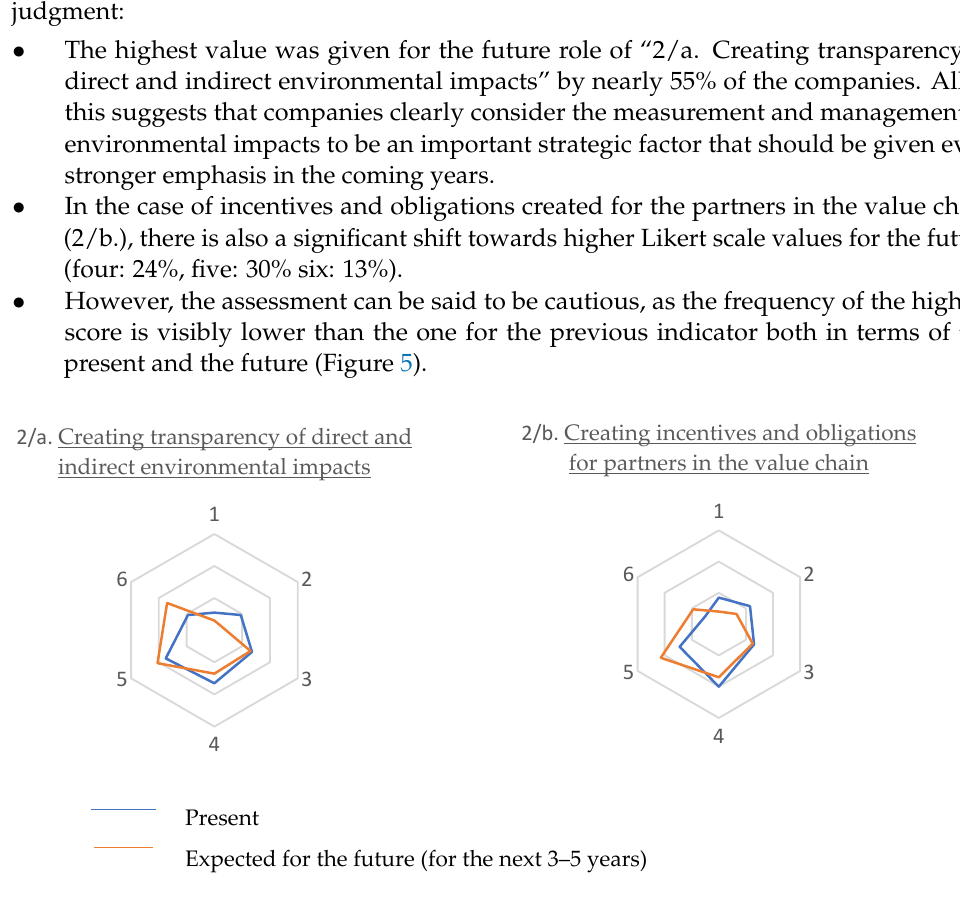
Figure 5. The spider web diagram of the scores given by the respondents at Stage 2 of becoming sustainable. Source: edited by authors.